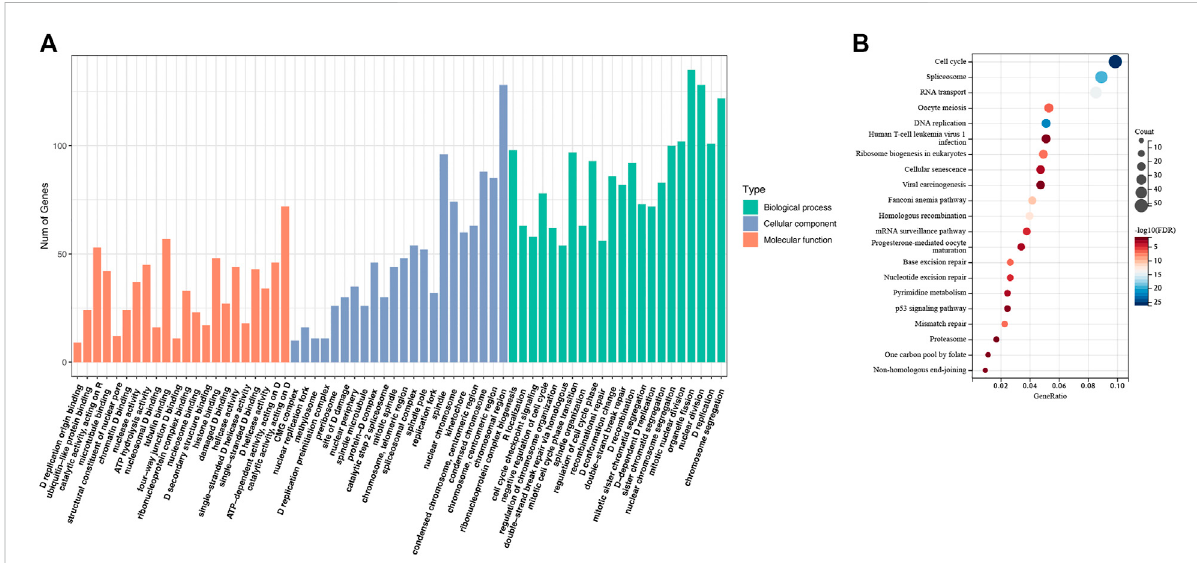
FIGURE 4 EnrichmentanalysisofthegenescorrelatedexpressedwithRAD51AP1. (A) GeneOntology(GO) enrichmentanalysis. (B) KyotoEncyclopedia of Genes and Genomes (KEGG) pathway analysis.